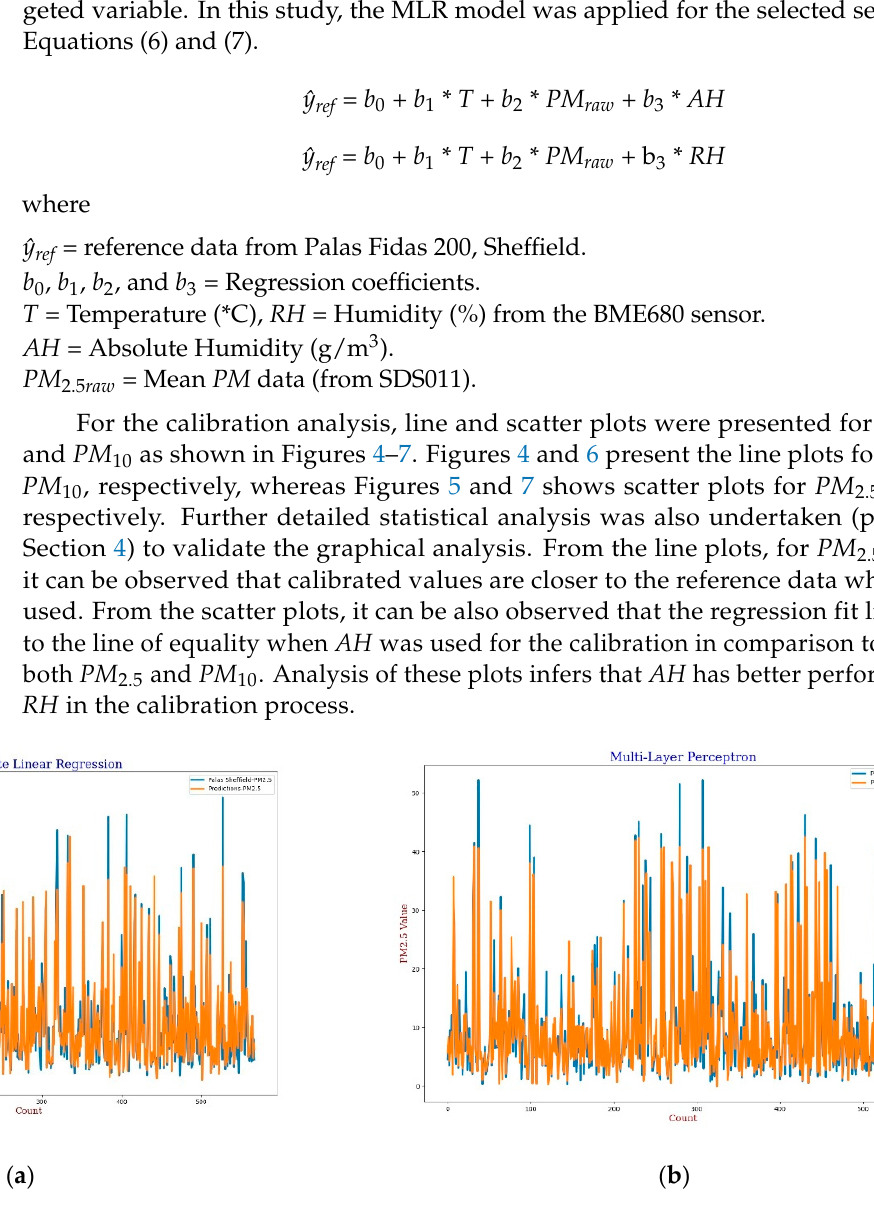
Figure 4. ( a ) MLR calibration plot for PM 2.5 using AH . Blue colour represents the reference data and orange colour represents the calibrated data; ( b ) MLR calibration plot for PM 2.5 using RH . Blue colour represents the reference data and orange colour represents the calibrated data.